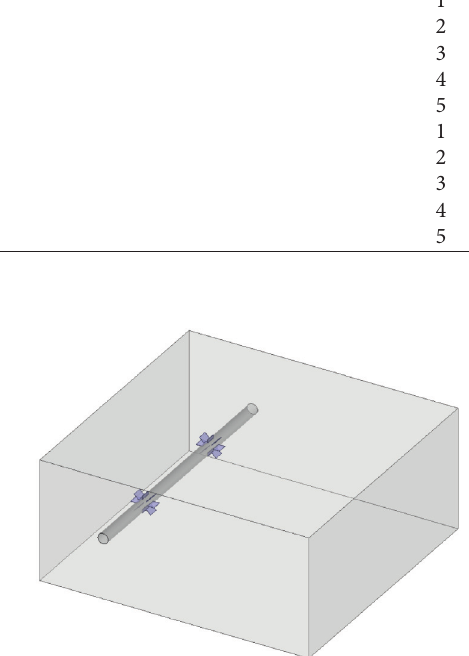
Figure 10: The calculation domain (with spoilers, case No. 12).